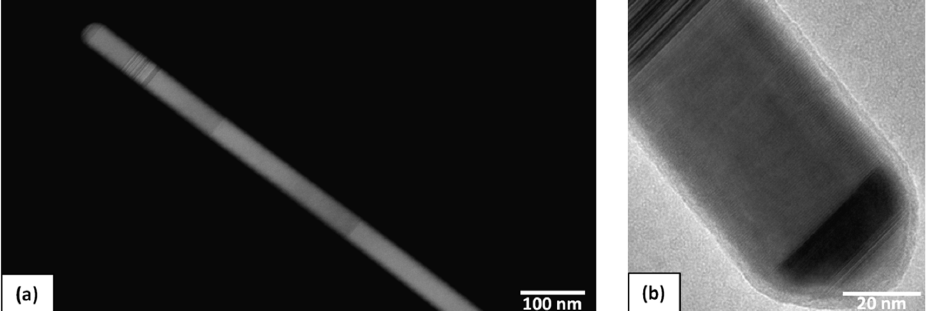
Figure 3. ( a ) HAADF-STEM image of a single GaAs NW; ( b ) HR TEM image of a single GaAs NW.